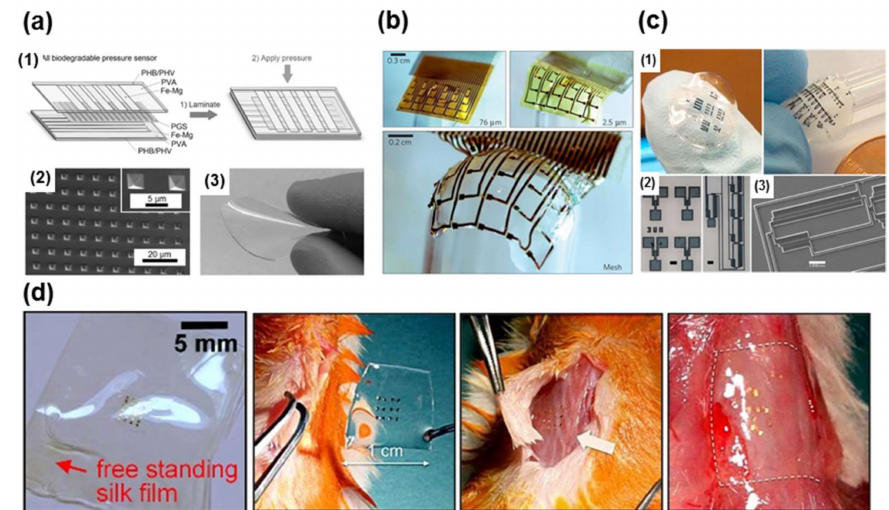
Figure 7. ( a ) Schematic design and fabrication of a fully biodegradable and flexible pressure sensor array from microstructured poly(glycerol sebacate) PGS films. ( 1 ) Schematic of the final fabrication step of the fully biodegradable pressure sensor and its device structure; ( 2 ) SEM image of the microstructured PGS film. Two-dimensional (2D) array of square pyramids are formed into PGS from a PDMS mold; ( 3 ) PGS biodegradable elastomer film. Reprinted with permission from Ref. [124], Copyright (2015), John Wiley and Sons; ( b ) Images of electrode arrays (76 µ m sheet in left top, 2.5 µ m sheet in right top and 2.5 µ m mesh in bottom panel) wrapped onto a glass hemisphere. Reprinted with permission from Ref. [126], Copyright (2010), Springer Nature; ( c ) Formation of complex microstructures via photolithography. ( 1 ) Large area micropatterns of PEDOT:PSS can be formed on flexible and conformable silk fibroin sheets, ( 2 ) Optical micrographs and ( 3 ) SEM images of PEDOT:PSS micropatterns on glass. Scale bars = 100 µ m. Reprinted with permission from Ref. [118], Copyright (2016), Elsevier; ( d ) Ultra-thin devices on a flexible silk substrate and the results of the animal toxicity test: image before (second image), shortly after (third image), and two weeks after (fourth image) implantation. Reprinted with permission from Ref. [117], Copyright (2009), AIP Publishing